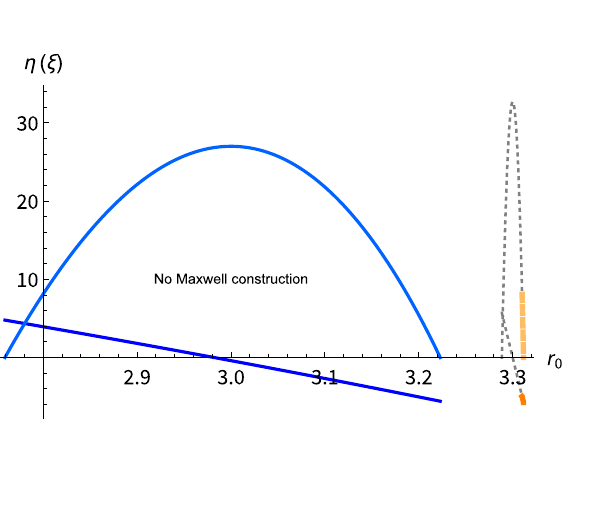
closed solid curve. The unstable FPOs, associated with the metric in the region r > r sh , form a section of arc, which might lead to an incomplete ring